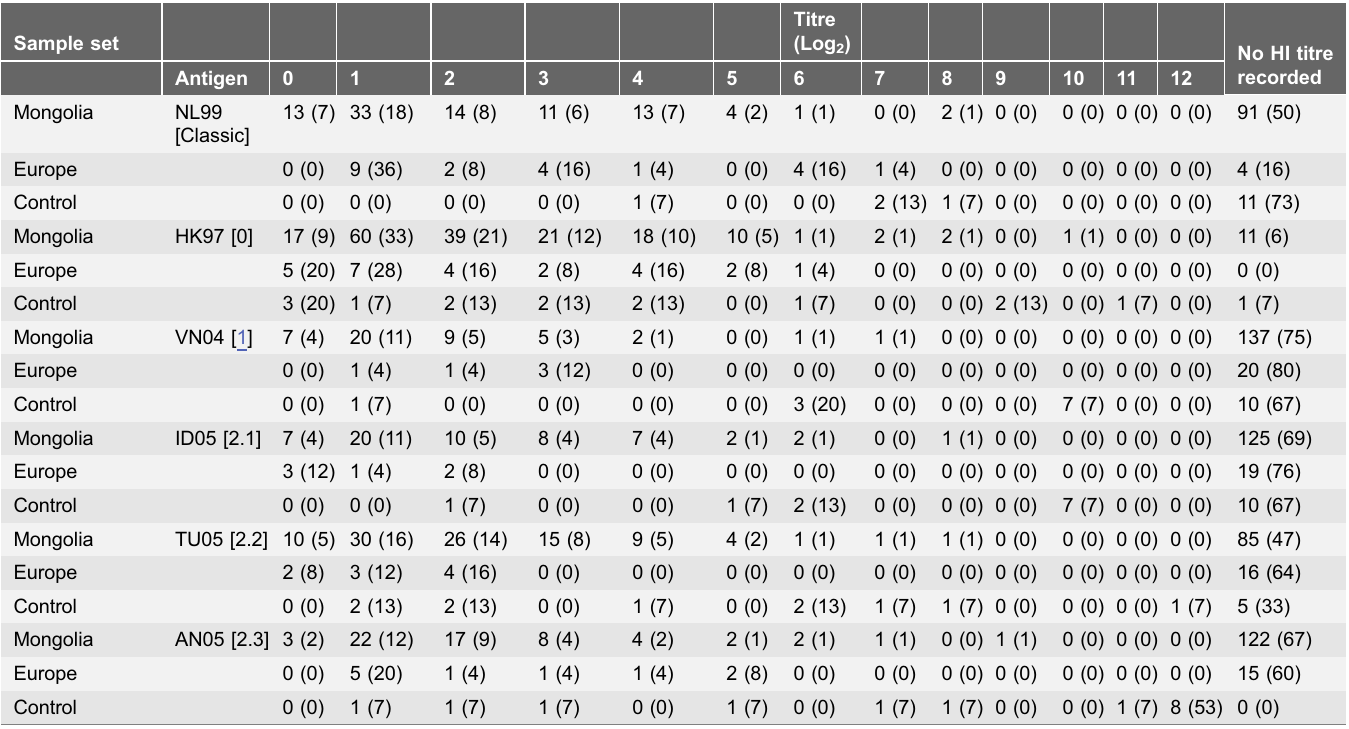
Table 3. Summary of hemagglutinin inhibition (HI)